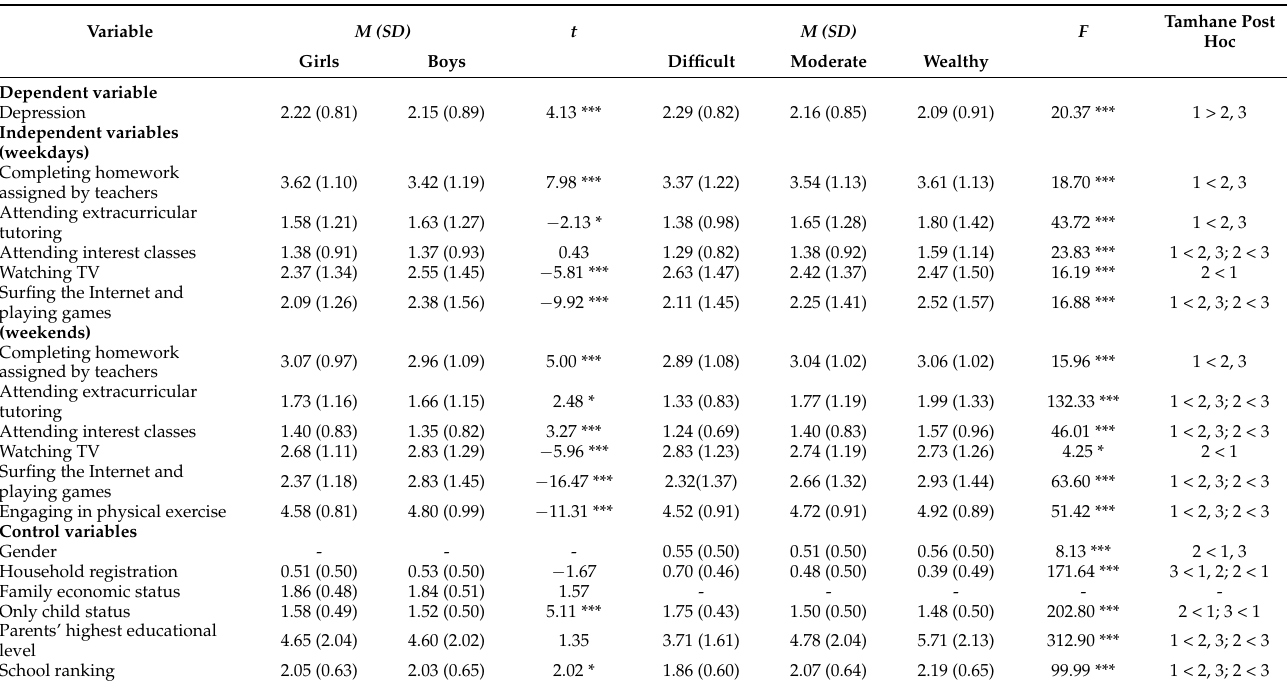
Table 1. Means and standard deviations of all variables by gender and family economic